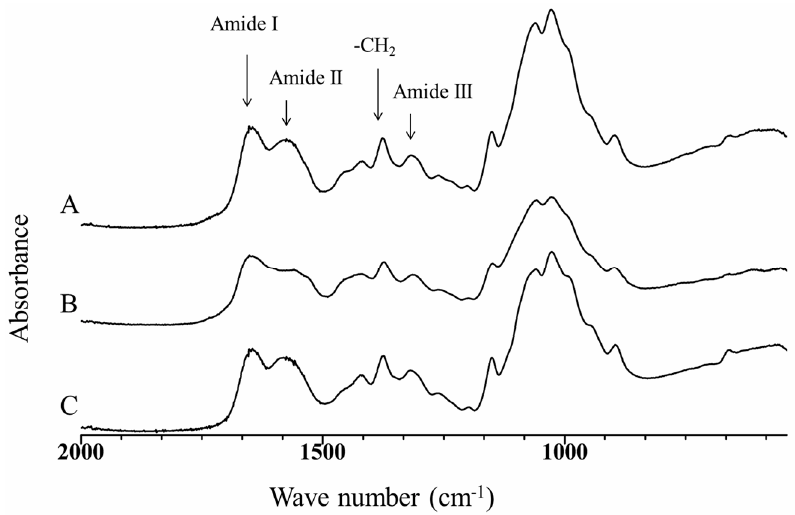
Figure 2. Fourier transform infrared spectrophotometer (FT-IR) spectra of ( A ) CsE aerogel; ( B ) CsB aerogel and ( C ) chitosan.